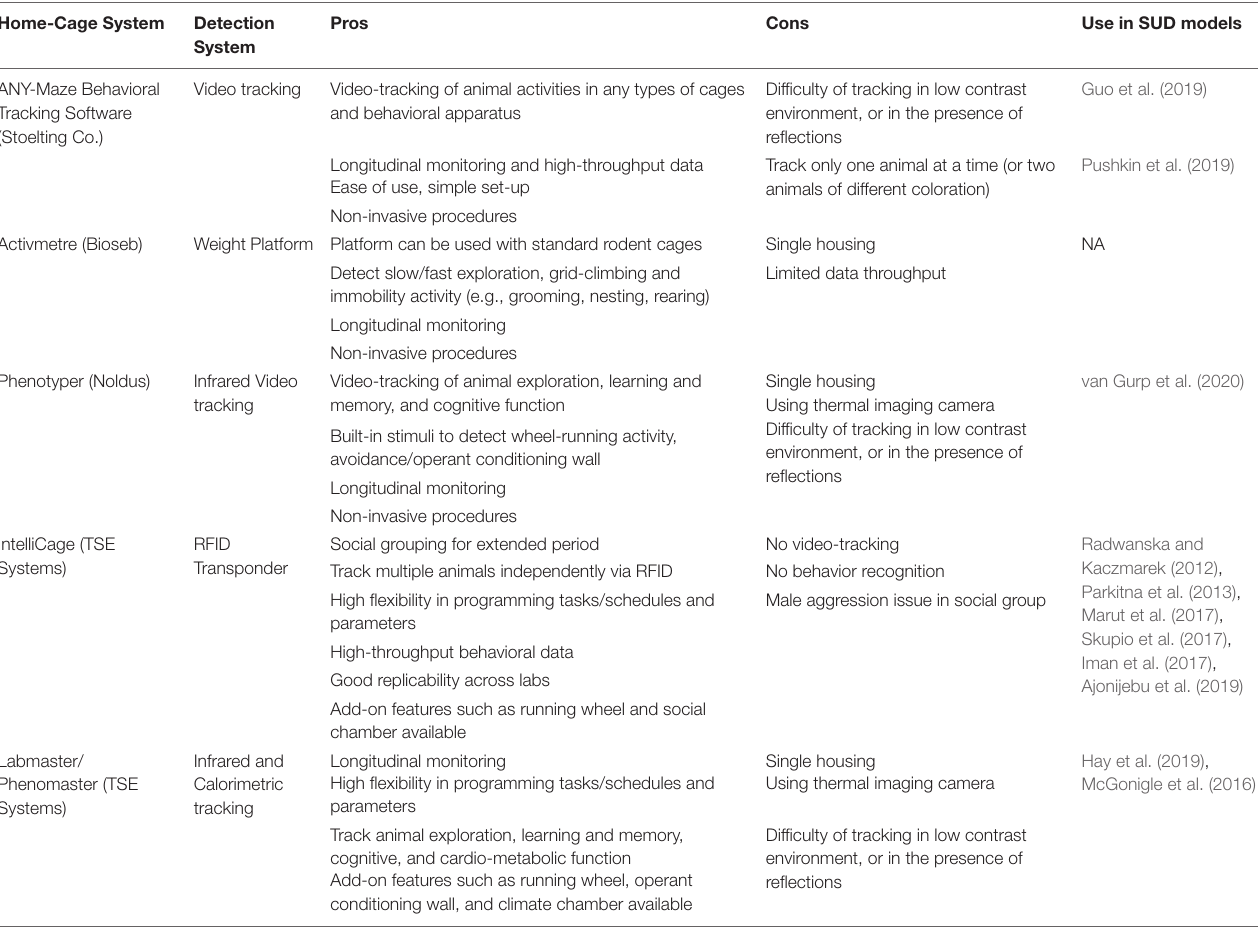
TABLE 3 | Summary of the available home-cage monitoring systems and their use in SUD in rodent models. Home-Cage